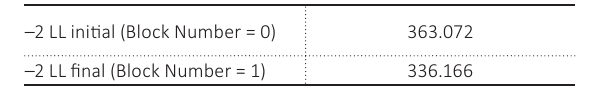
Table 6. Comparison of values between –2 LL